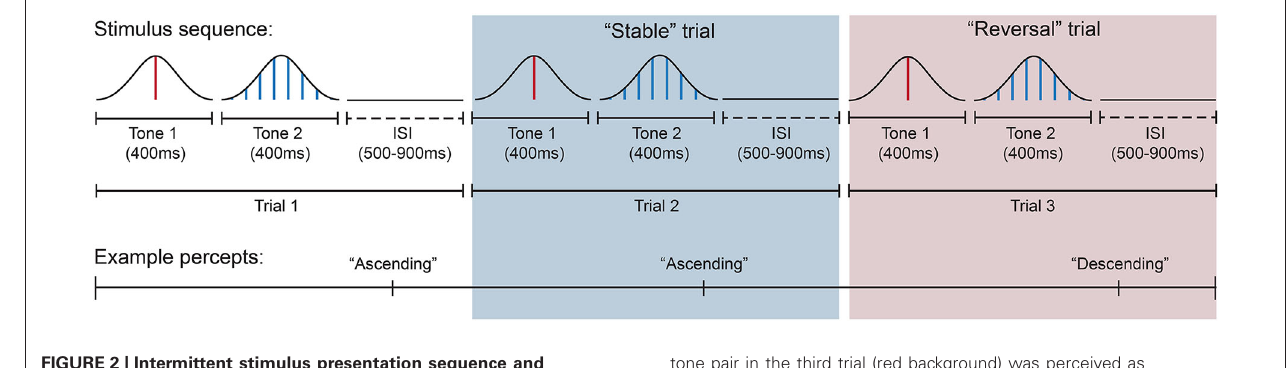
FIGURE 2 | Intermittent stimulus presentation sequence and corresponding example percepts across trials . In this example, the subject reports the perceived pitch direction of the tone pair as ascending in the first trial (white background) and also ascending in the second trial (blue background). Thus the second trial would be categorized as a “stable” trial because perceived pitch direction remained the same across successive trials. The